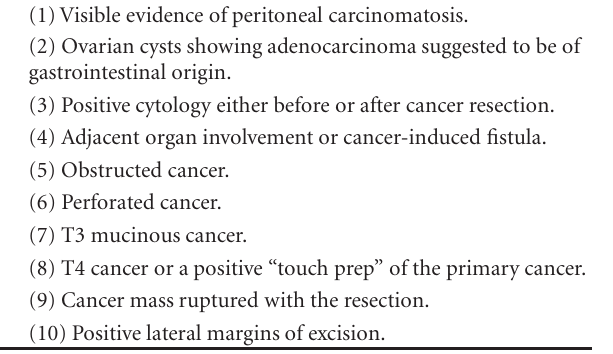
Table 2: Patients with primary colorectal cancer identified to be at high risk for local-regional recurrence and/or peritoneal carcinomatosis.